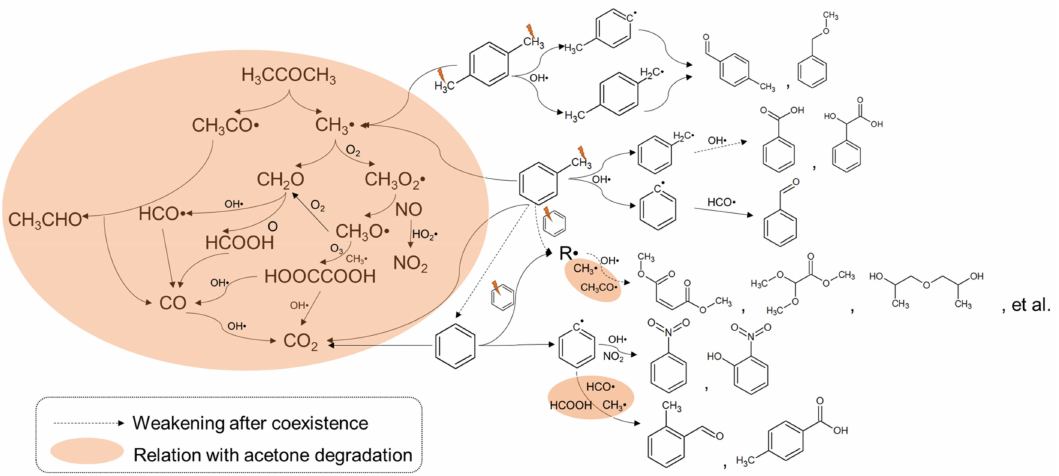
Figure 11. Schematic diagram of the influence mechanism of BTEX on the acetone degradation